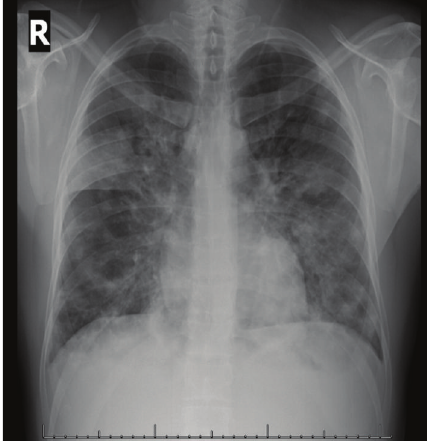
Figure 1: Initial chest X-ray at the ICU, showing diffuse bilateral cotton-like infiltrates.